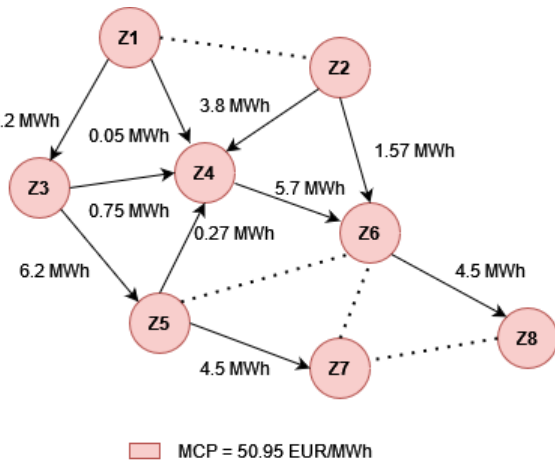
Figure 7. Transmitted quantities on the network in the first simulated scenario.